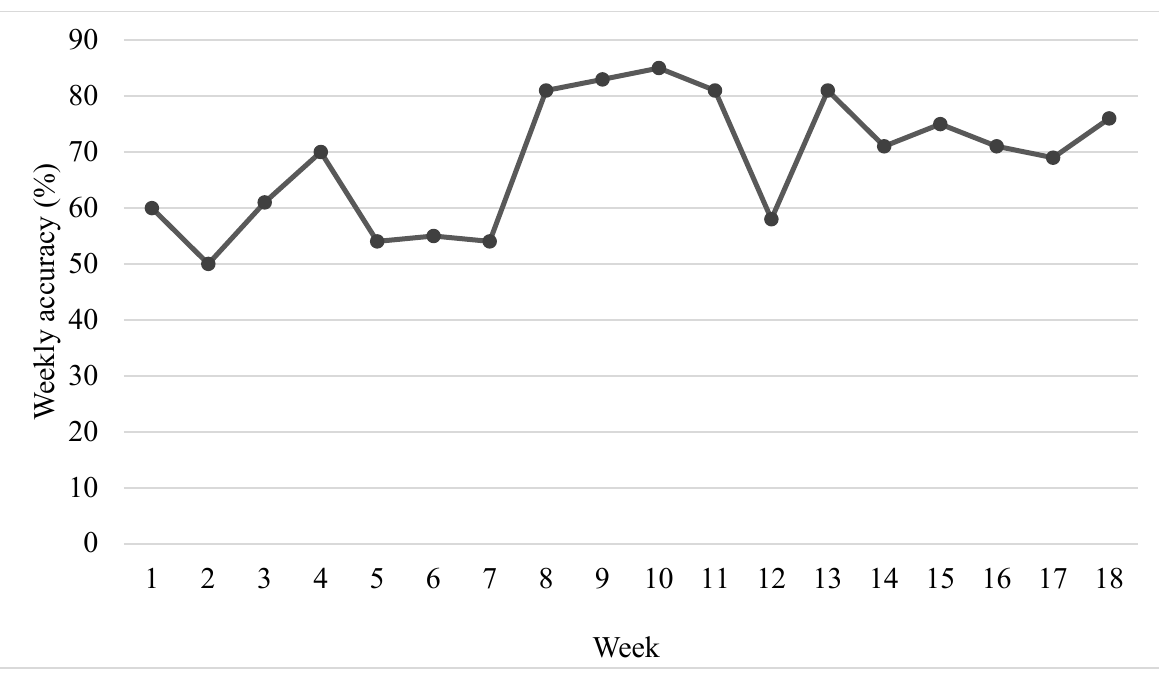
Weekly Accuracy of the Verified